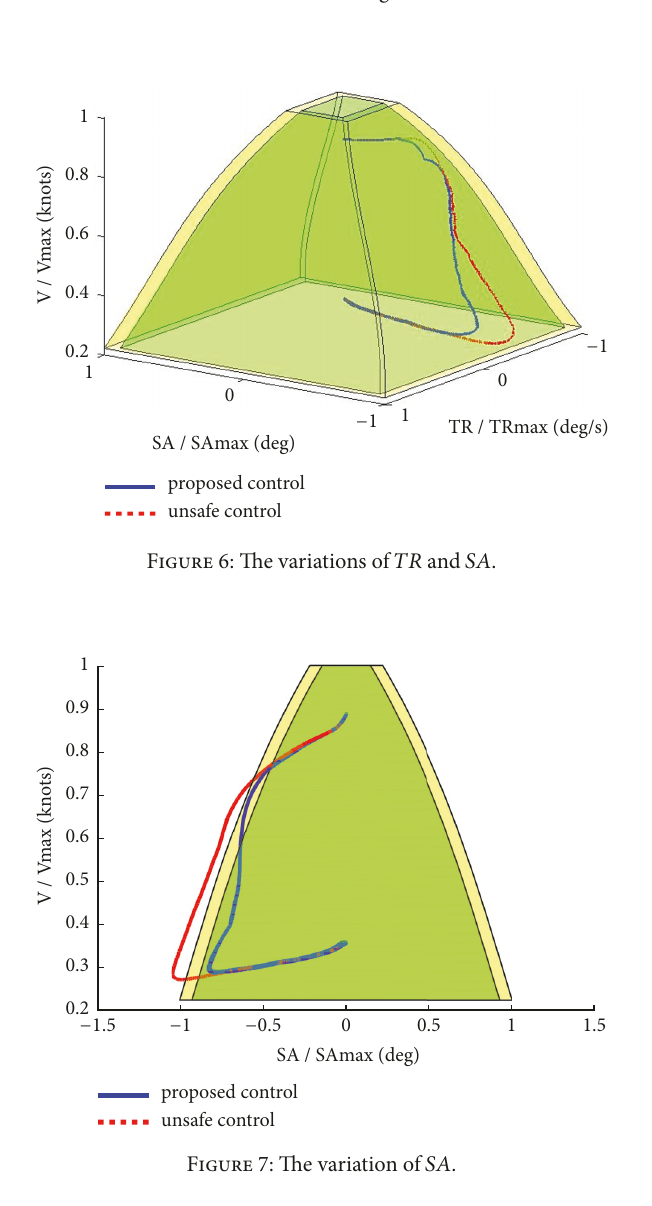
Figure 5: The course angle of ACV.